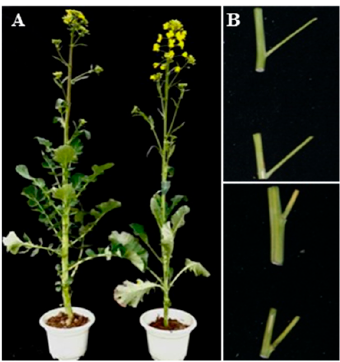
Figure 1. Phenotypes of 6098B and Purler showing variation in branch angle. ( A ) 6098B and Purler at early flowering. ( B ) Upper panel : 6098B showing lax branch angle (52°), lower panel : erect branch angle of Purler (22°).